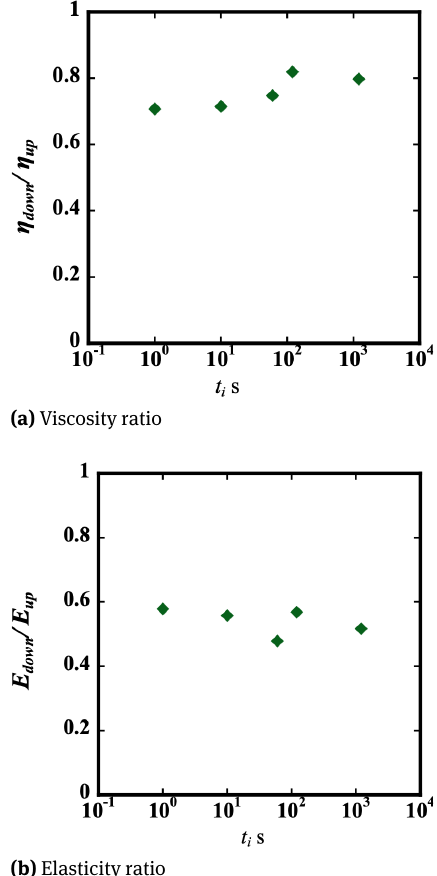
Figure 10: Influence of the creep time on the flow characteristics below the yield point for a maximum applied stress of 1 Pa and stress-ramp rate of 0.1 Pa/s. (a) The viscosity ratio and (b) the elasticity ratio. The creep time hardly influences the flow history of the viscoelastic